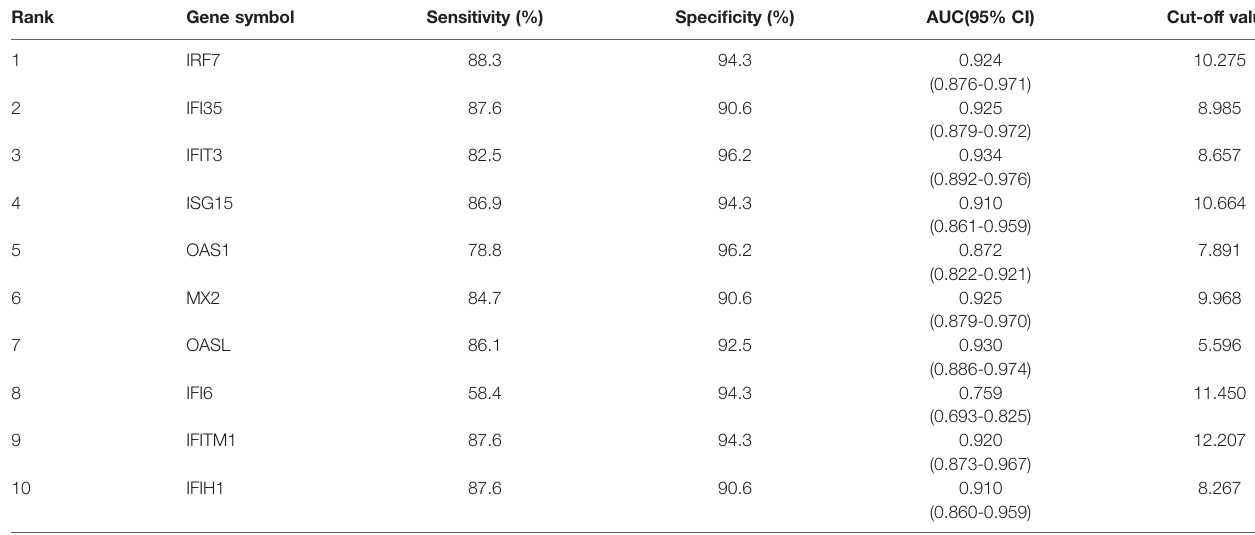
FIGURE 2 | PPI network of DEGs and three cluster modules extracted by MCODE. (A) Interaction network between proteins coded by DEGs. Each node represents a protein, while each edge represents one protein – protein association. Red and green rectangles represent the upregulated and downregulated genes respectively. Three cluster modules extracted by MCODE. Cluster 1 (B) had the highest cluster score (MCODE score = 18.737), followed by cluster 2 (C) (MCODE score = 6.286), and cluster 3 (D) (MCODE score = 4). TABLE 1 | The sensitivity and speci fi city of the 10 hub genes in detecting